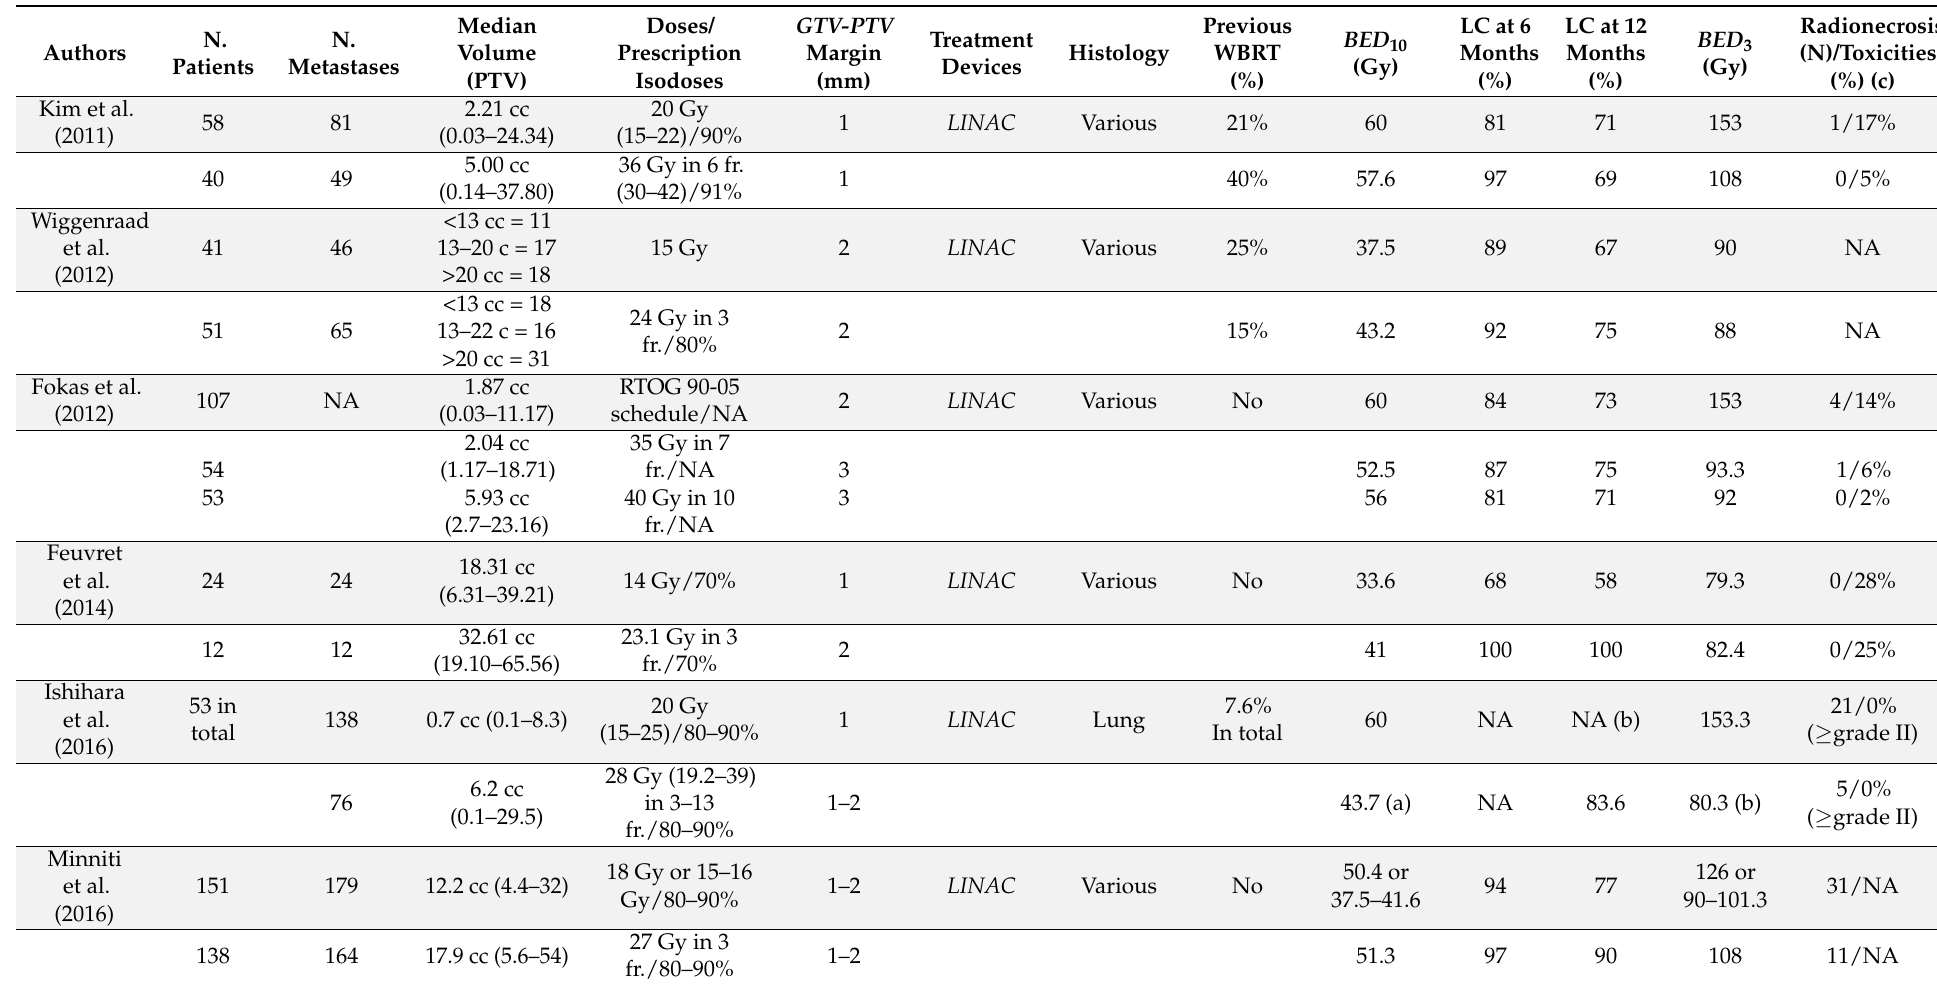
Table 1. Comparative retrospective studies of single-fraction (grey lines) vs. multi-fraction (white lines), local control (LC), BED 10 , BED 3 , radionecrosis and toxicities.